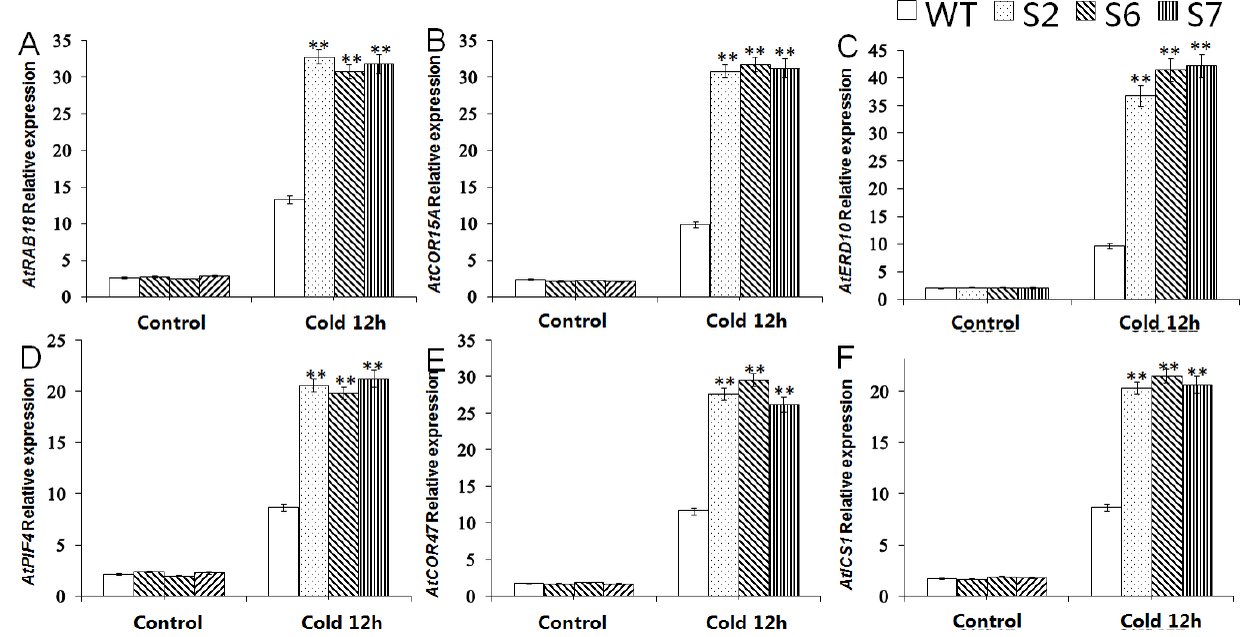
Figure 6. Expression levels of 6 cold stress related genes ( A ) RAB18 , ( B ) COR15A , ( C ) ERD10 , ( D ) PIF4 , ( E ) COR47, and ( F ) ICS1 in WT and transgenic Arabidopsis under low temperature stress. The standard error was the average of 3 repeated tests. The asterisk above the column indicated that there was a significant difference between the transgenic lines and the WT lines under cold stress (** p ≤ 0.01).